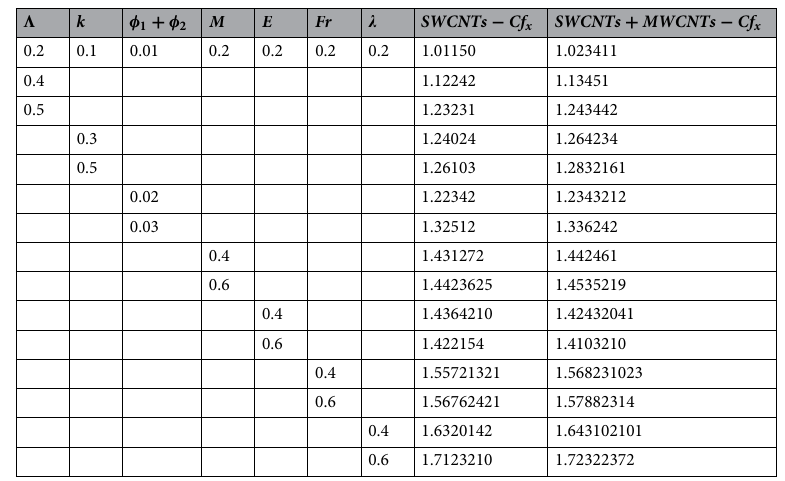
0.5 Table 1. Skin friction C fx Re x for different parameters regarding blood-based hybrid nanofluid.